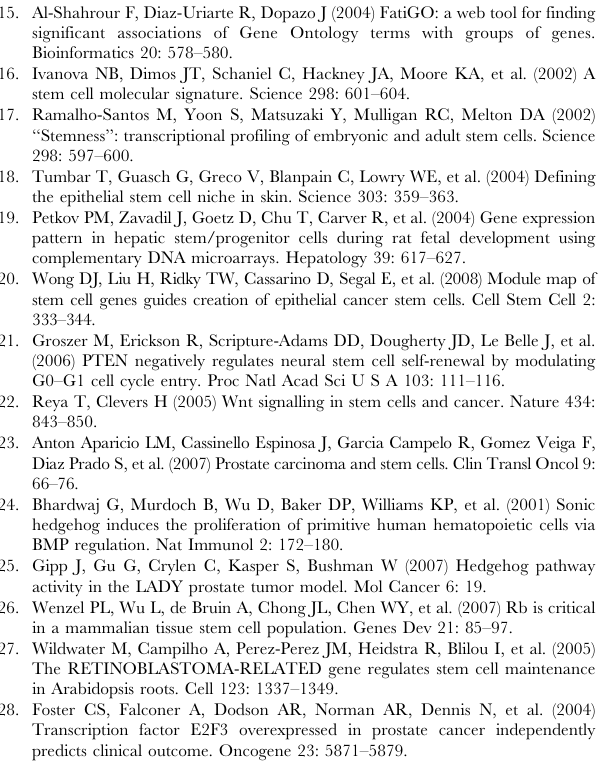
Table S14 TGF- b target genes in stem/progenitor clusters. A) This list of TGF b -target genes was obtained after analysis of the